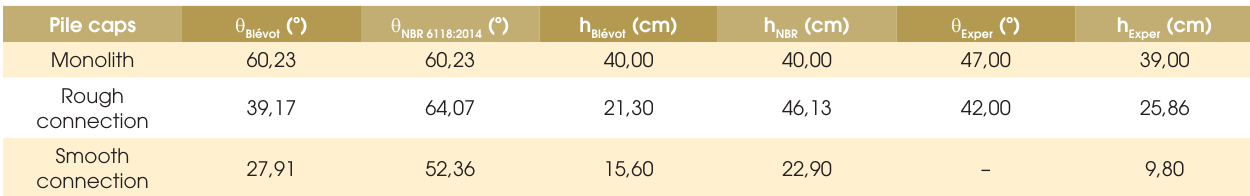
Table 4 – Inclination of the strut, in function of the